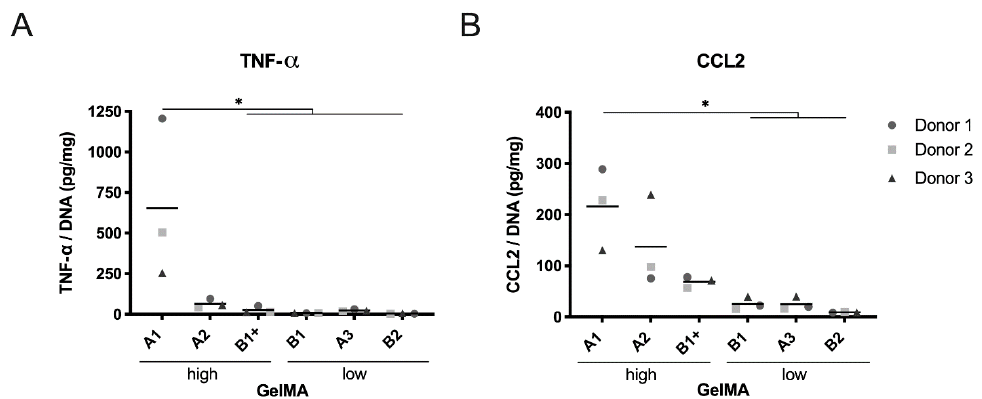
Figure 3. Cytokine production of PBMCs in response to GelMA hydrogels. TNF- α ( A ) and CCL-2 ( B ) protein levels in the culture supernatant of PBMCs after a 24-h culture on six hydrogels from five different GelMAs. GelMA B1 was supplemented with LPS to obtain high endotoxin GelMA B1+. n = 3 PBMC donors. Symbols represent the mean of five technical replicates per donor and are expressed in pg protein/mg DNA. *: p < 0.05.